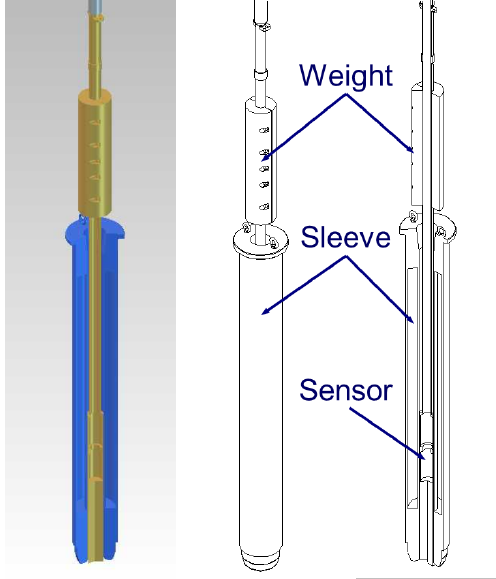
Fig. 1. The heating rate measurement facility at the CN hole of HANARO.